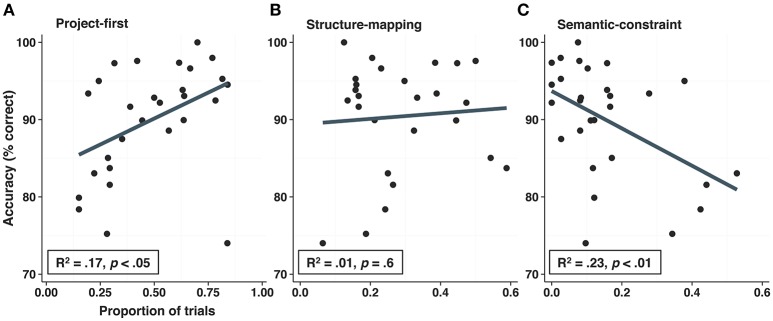
Correlations between strategy use and overall accuracy (mean percent correct). Use of the project-first strategy was positively correlated with accuracy (A), whereas use of the structure-mapping strategy was unrelated to accuracy (B), and use of semantic-constraint strategy was negatively correlated related with accuracy (C).